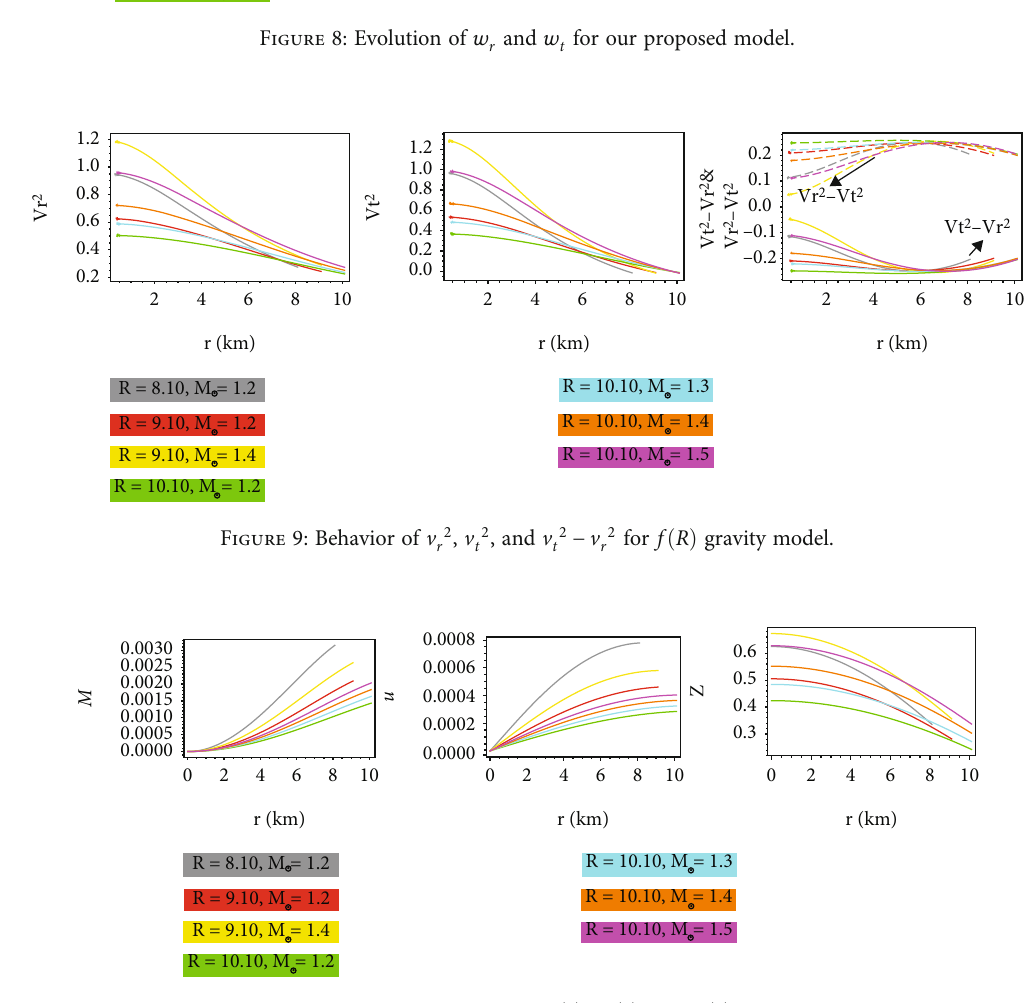
Figure 10: Behavior of M ð r Þ , U ð r Þ , and Z ð r Þ